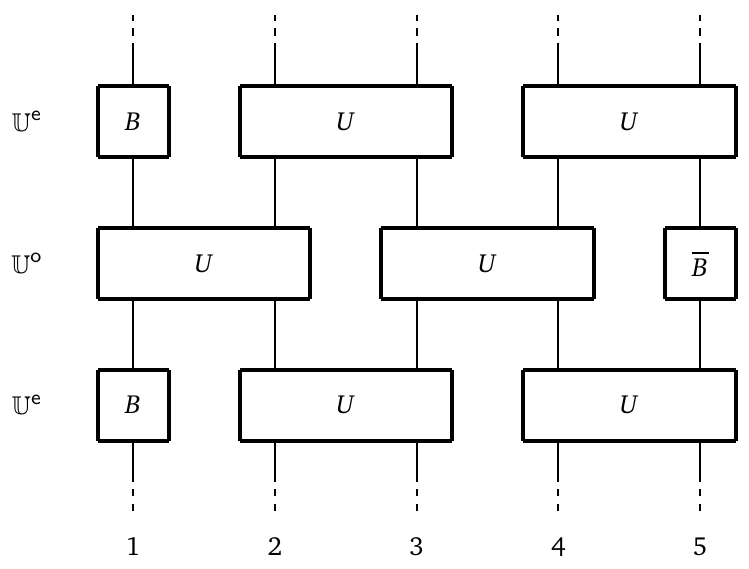
Figure 2: Pictorial representation of the discrete time dynamics for open boundary conditions. Note that the time flows